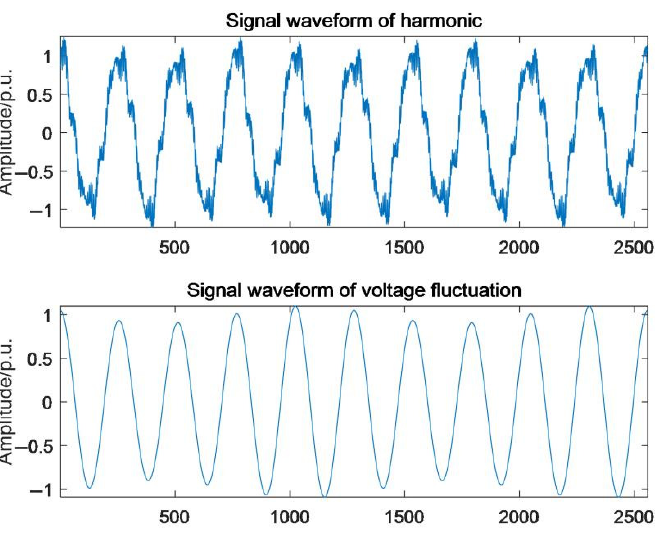
Figure 3. Sensitivity analysis of block length in different data. ( a ) Sensitivity curve of block length in measured data. ( b ) Sensitivity curve of block length in synthetic data.